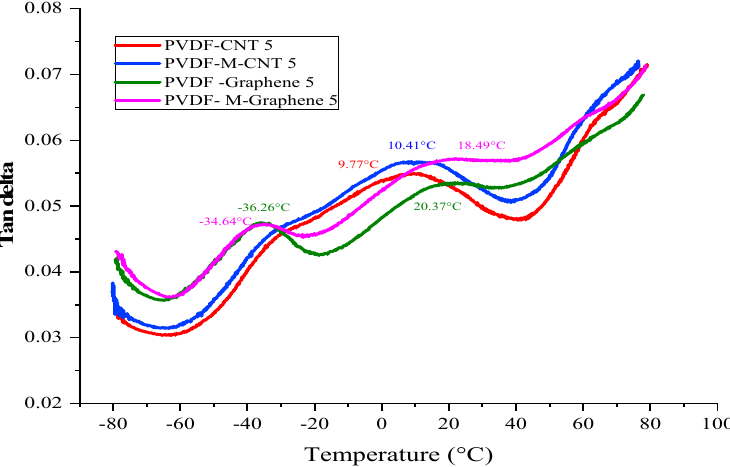
Figure 11. Delta T of the treated and untreated MWCNT/CNF-PVDF nanocomposites.